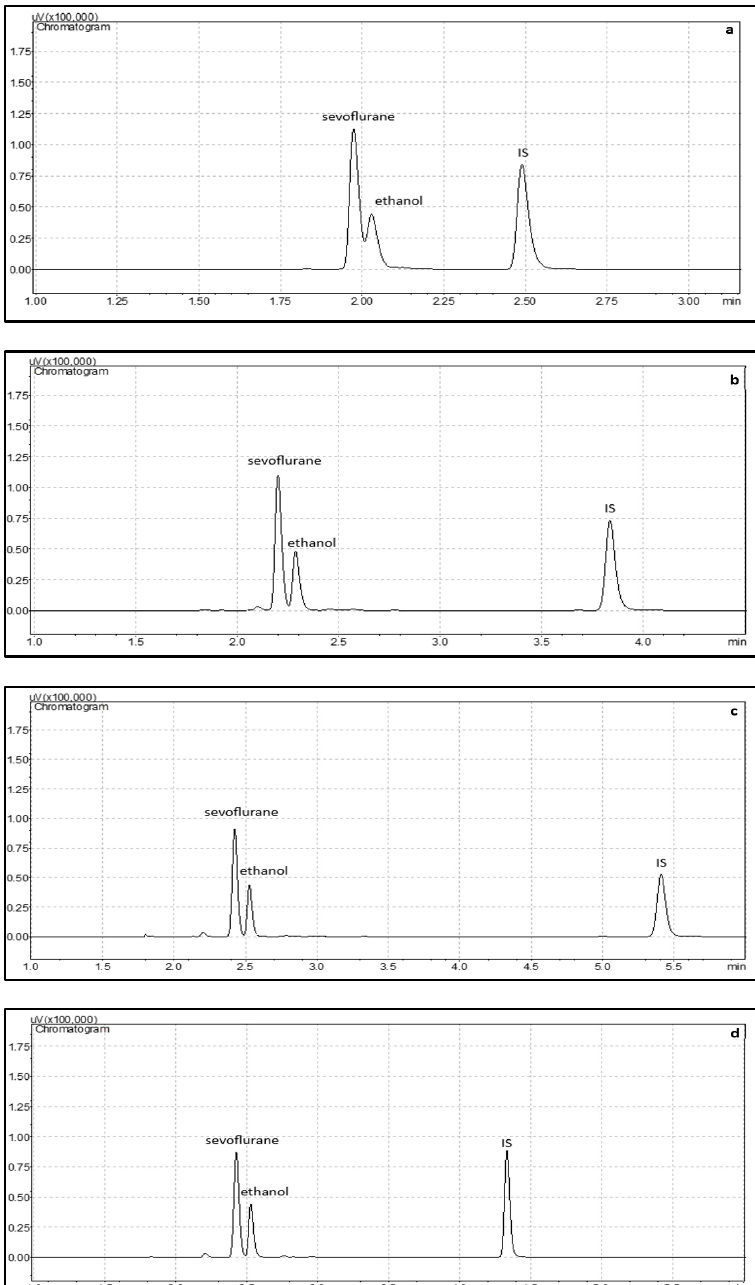
Figure 2. Chromatograms of sevoflurane, ethanol and IS during optimization: a) oven T = 150 °C; b) oven T = 100 °C; c) oven T = 80 °C; d) oven T ramp from T = 80 °C to 120 °C at a rate of 40 °C/min to 120 °C. The optimized method is reported in d, where a good separation between the sevoflurane and ethanol peaks was obtained.